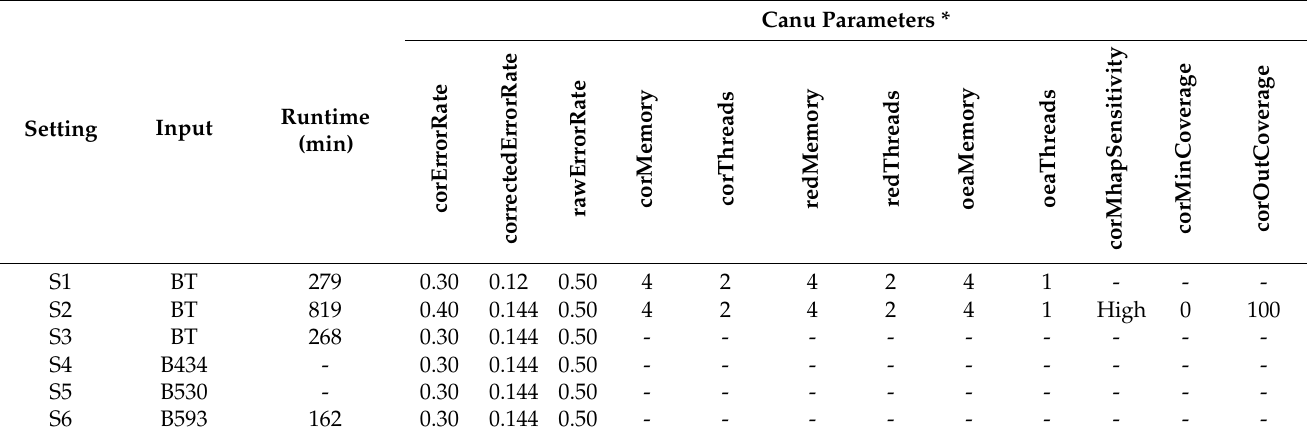
Table 1. Description of the six different settings adopted for Canu assembly and parameters variations. Setting S1, S2, and S3 use the combined basecalled reads from the three sequencing experiments (BT), while S4, S5, and S6 use separate reads (B434, B530, B593, respectively). De novo assembly with default Canu parameters for S4 and S5